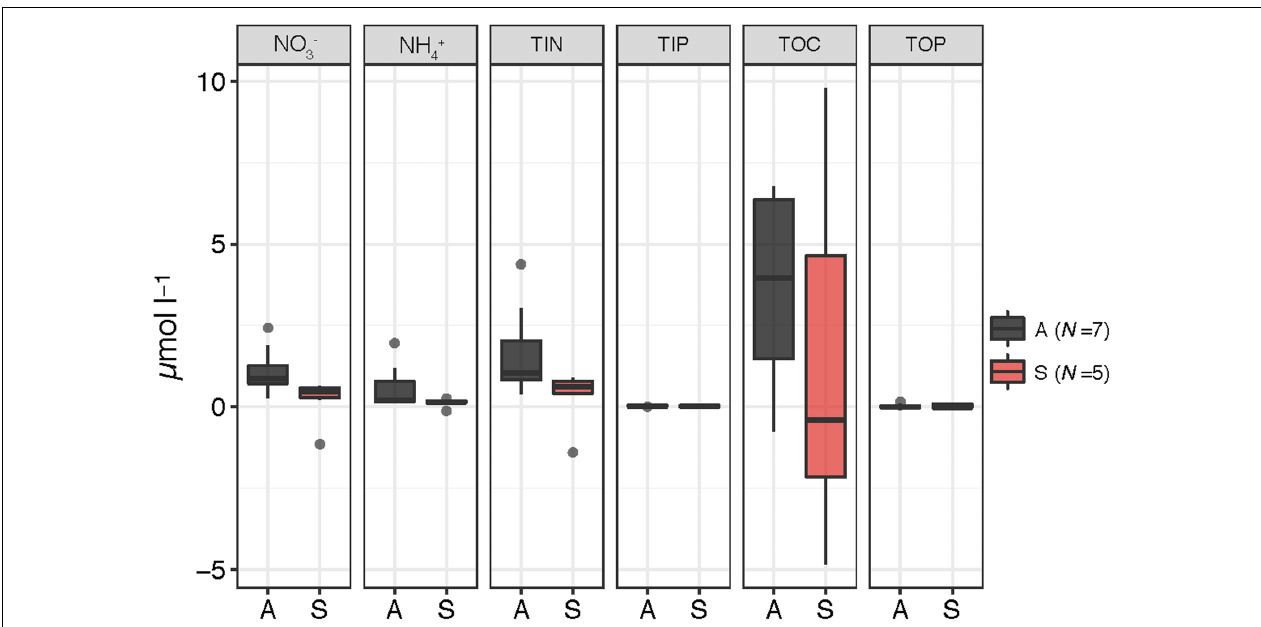
FIGURE 2 | Box-plots showing the variation in the concentration ( µ mol l − 1 ) of NO − 3 , NH + 4 , total inorganic nitrogen (TIN), total inorganic phosphorous (TIP), total organic phosphorous (TOP), and total organic carbon (TOC) after the aerosol additions – with respect to the values approximately 3 h before the addition – inside the A ( N = 7) and S ( N = 5) microcosms. The boxes indicate median and quartile values. The whiskers extend to 1.5 times the interquartile range. Values above or below this boundary are displayed as